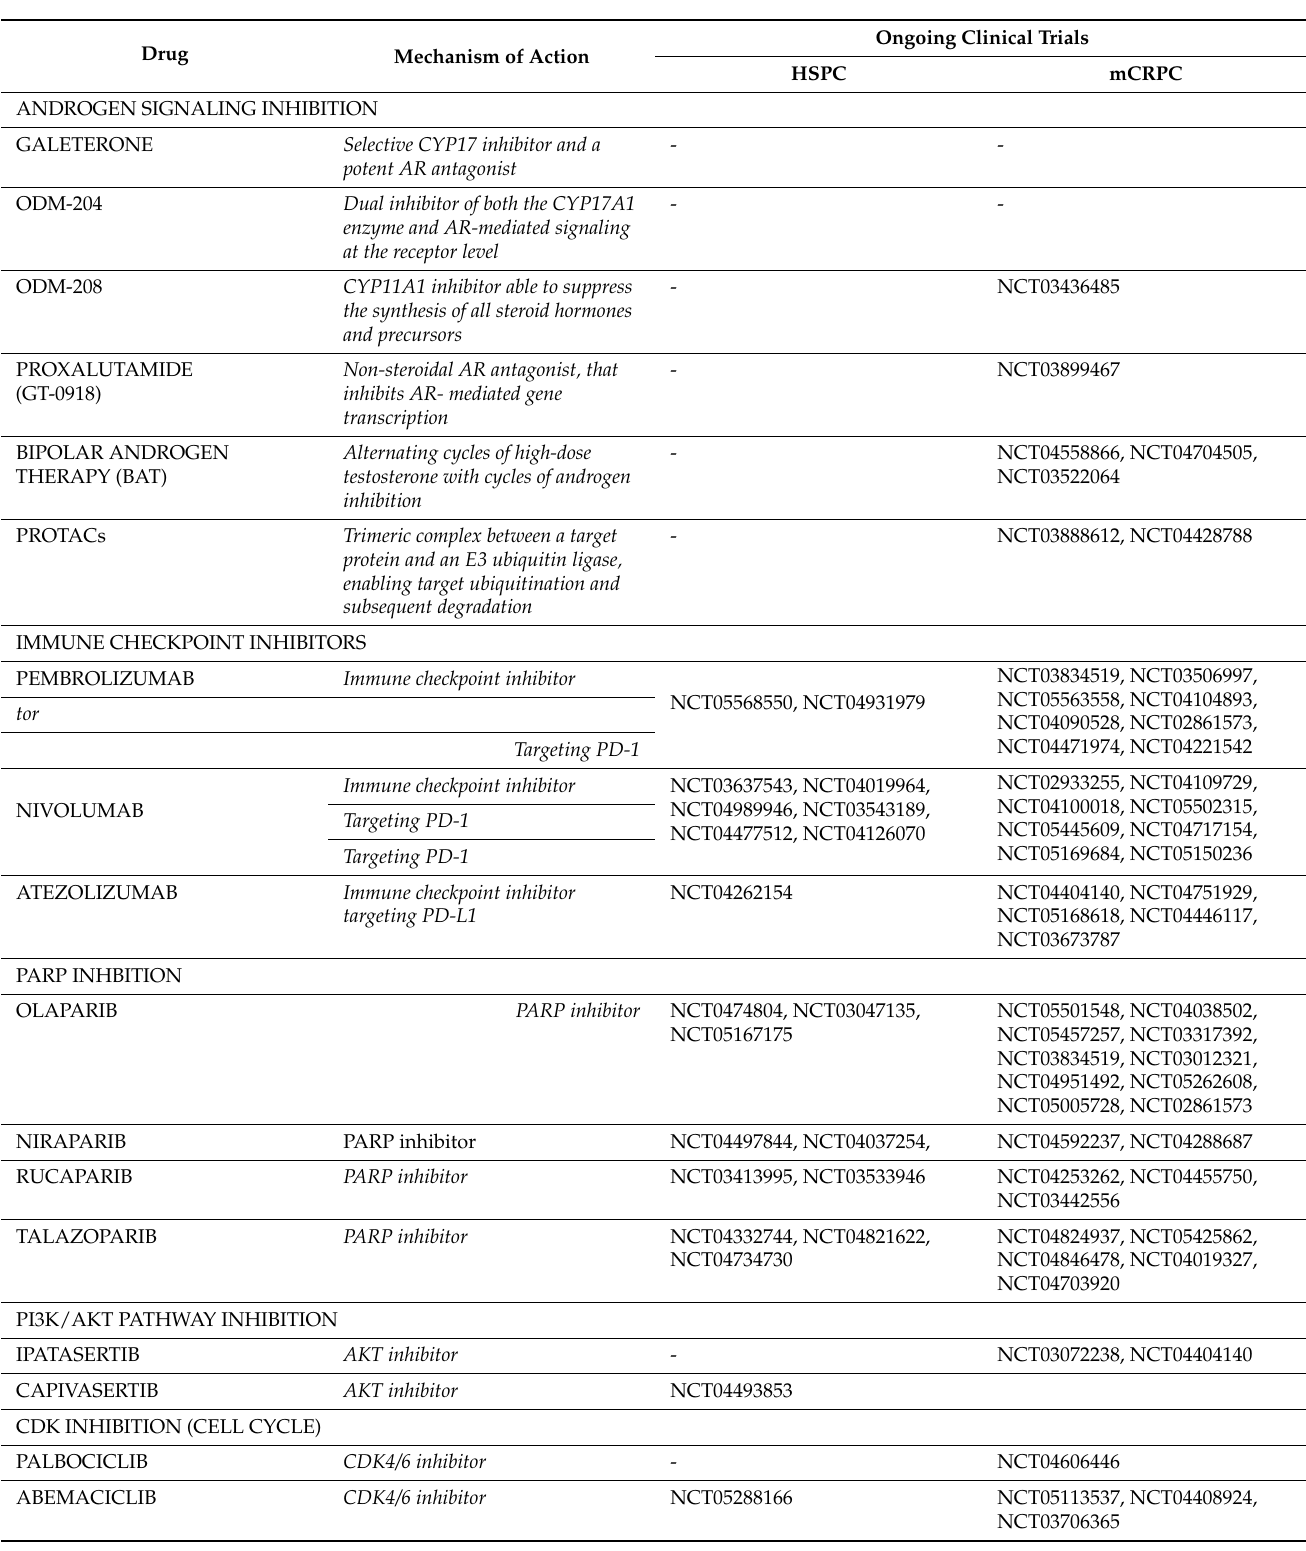
Table 2. Ongoing trials for emerging drugs in prostate